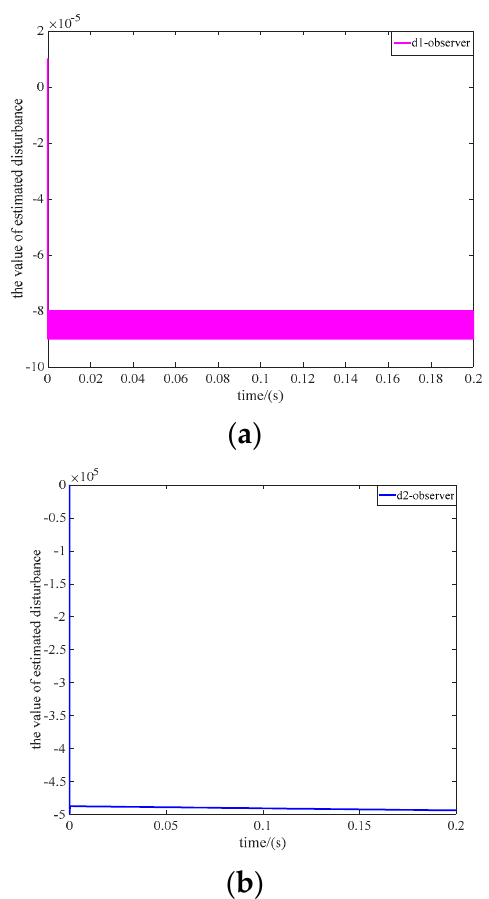
Figure 4 . The estimated value based on the finite-time observer. ( a )The estimated value of d 1 based on the finite-time observer. ( b )The estimated value of d 2 based on the finite-time observer. Table 5 . The comparative simulation results of start up